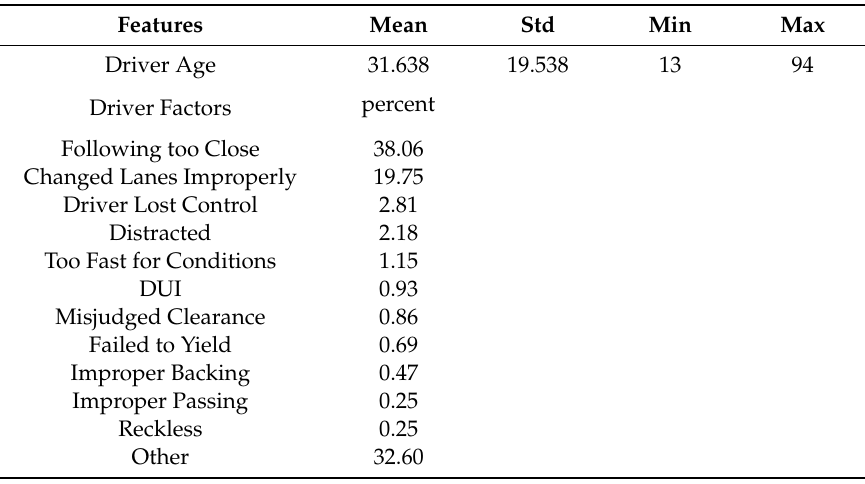
Table 4. Data description for driver-related